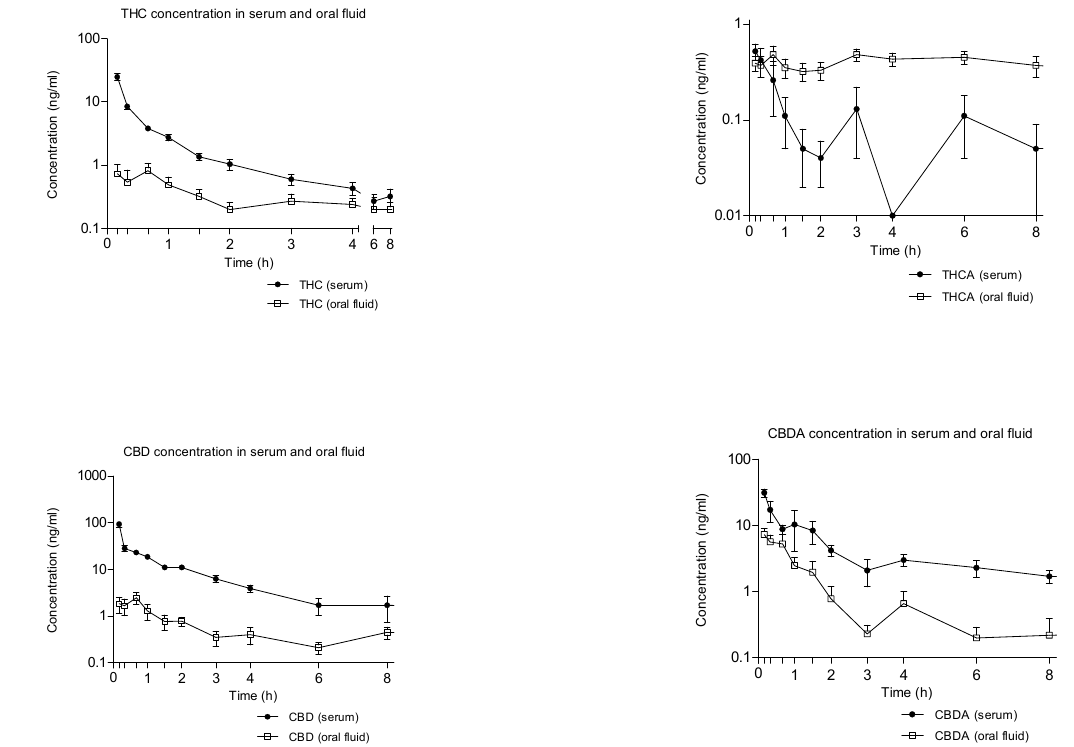
Figure 3. Mean time-course of THC, CBD, and their acidic precursors (THCA and CBDA) concentrations (logarithmic scale) in serum and oral fluid following the administration of vaporized cannabis.